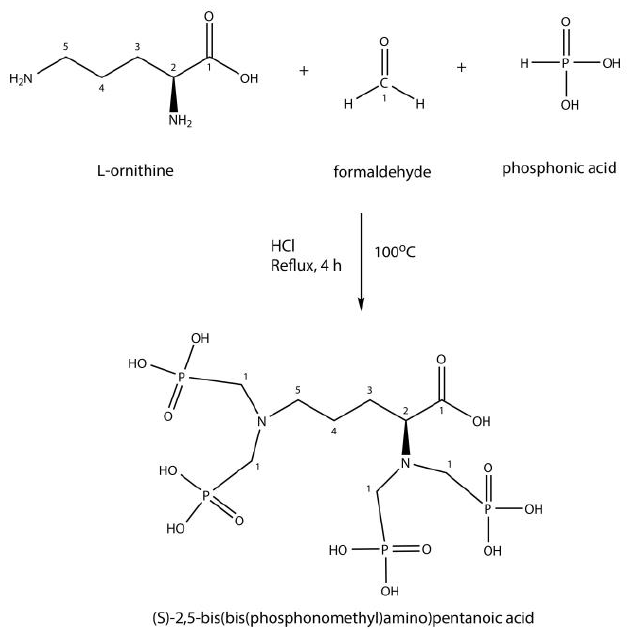
Figure 1. DPAPA synthesis reactions (Mannich-type reaction).